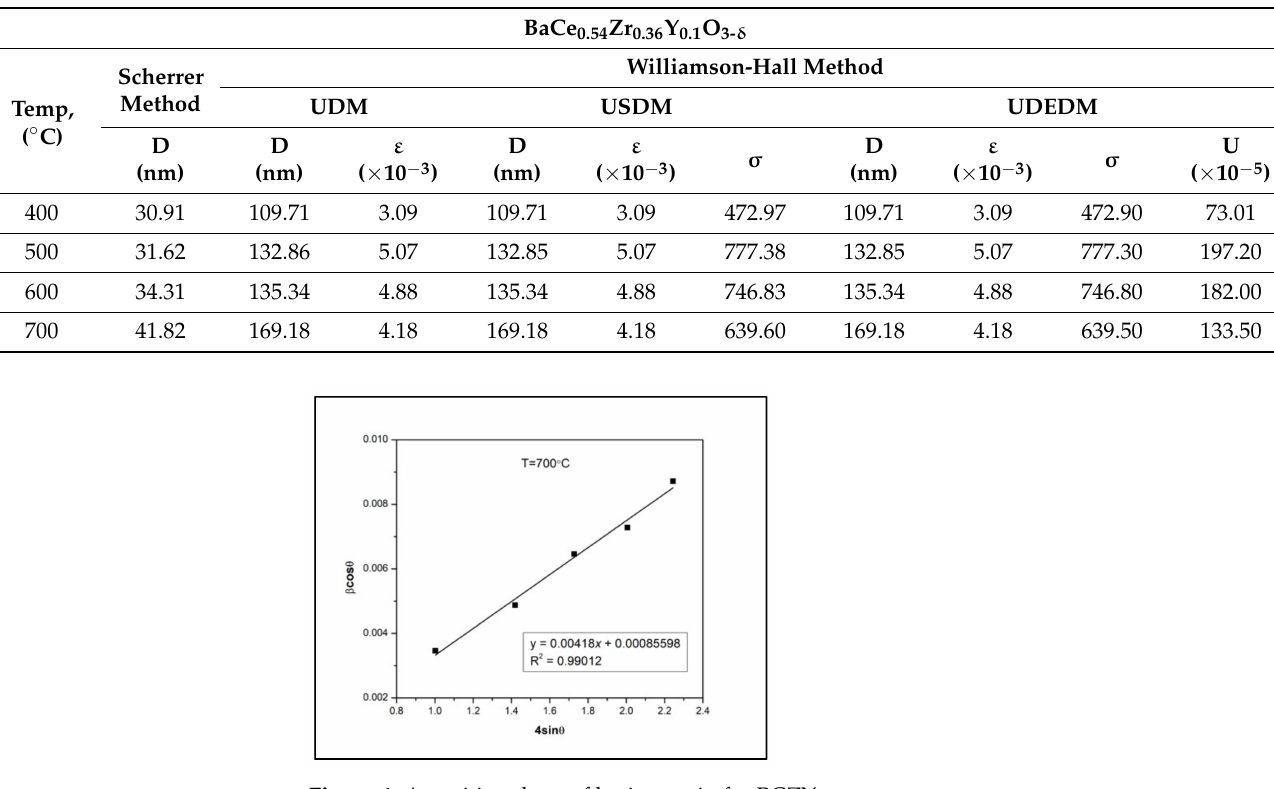
Figure 4. A positive slope of lattice strain for BCZY.